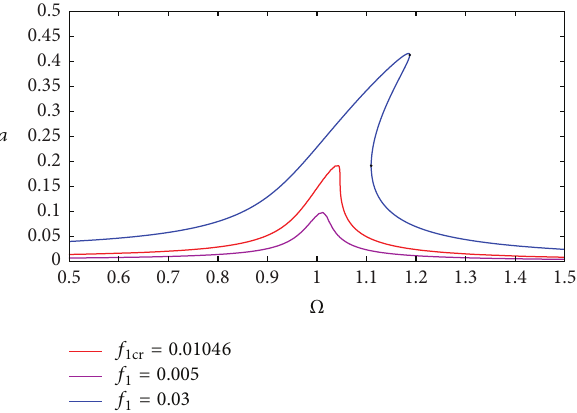
Figure 10: Amplitude-frequency relationship of the primary res- onance for the controlled system under different excitation force amplitude with time delay 𝜏 = 𝜋/4 ( 𝜁 1 = 0.025 , 𝜁 3 = 0.05 , 𝑘 = 1 , and ̂𝜆 = 0.4